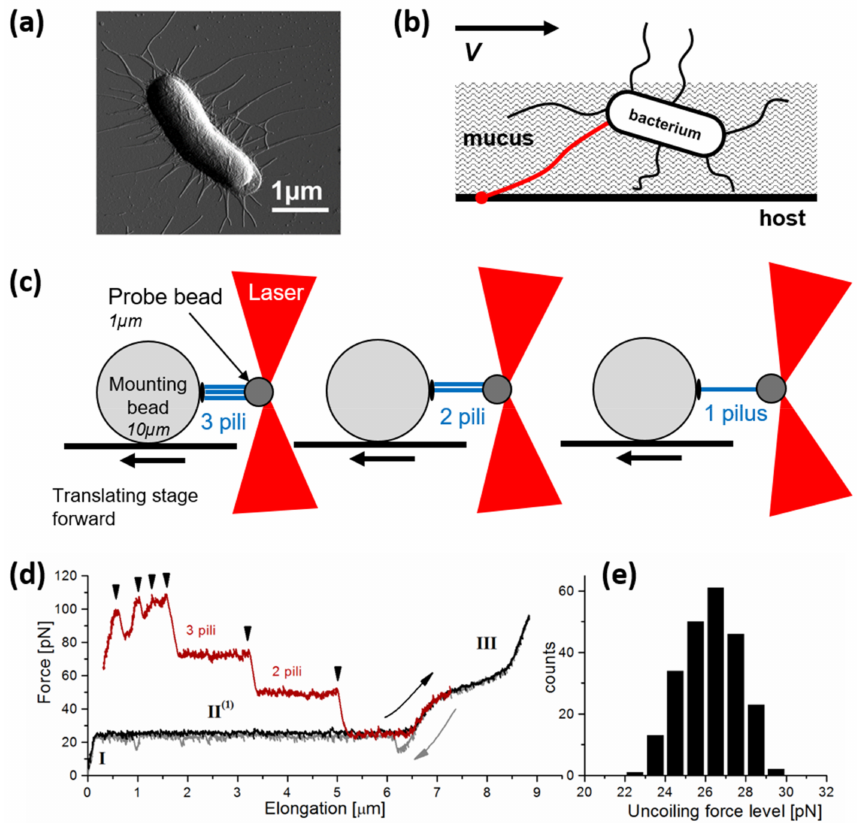
Figure 2. Pili-based adhesions. ( a ) AFM vertical deflection image of an Escherichia coli cell expressing F1C pili. Reproduced with permission from [124]. ( b ) Illustration of a bacterial cell embedded in a mucus layer and attached to a host cell, able to withstand a physiological shear flow thanks to its pili. ( c ) A piliated bacterial cell immobilized on a large «mounting bead» interacts through its three pili to a small probe bead trapped by a laser beam. When retracting the stage, the pili are extended and unfolded until one breaks, then another one until the end of the retraction where a single pilus remains, probably the longer one. Adapted with permissions from [34]. ( d ) Force diagram corresponding to the experiment represented in panel ( c ), showing the force-extension curve of F1C pili during their unfolding (force plateaus) in a step-like manner until one single pilus is reached. ( e ) Distribution of the individual unfolding force values reported from the force plateau mean values. Reproduced with permission from